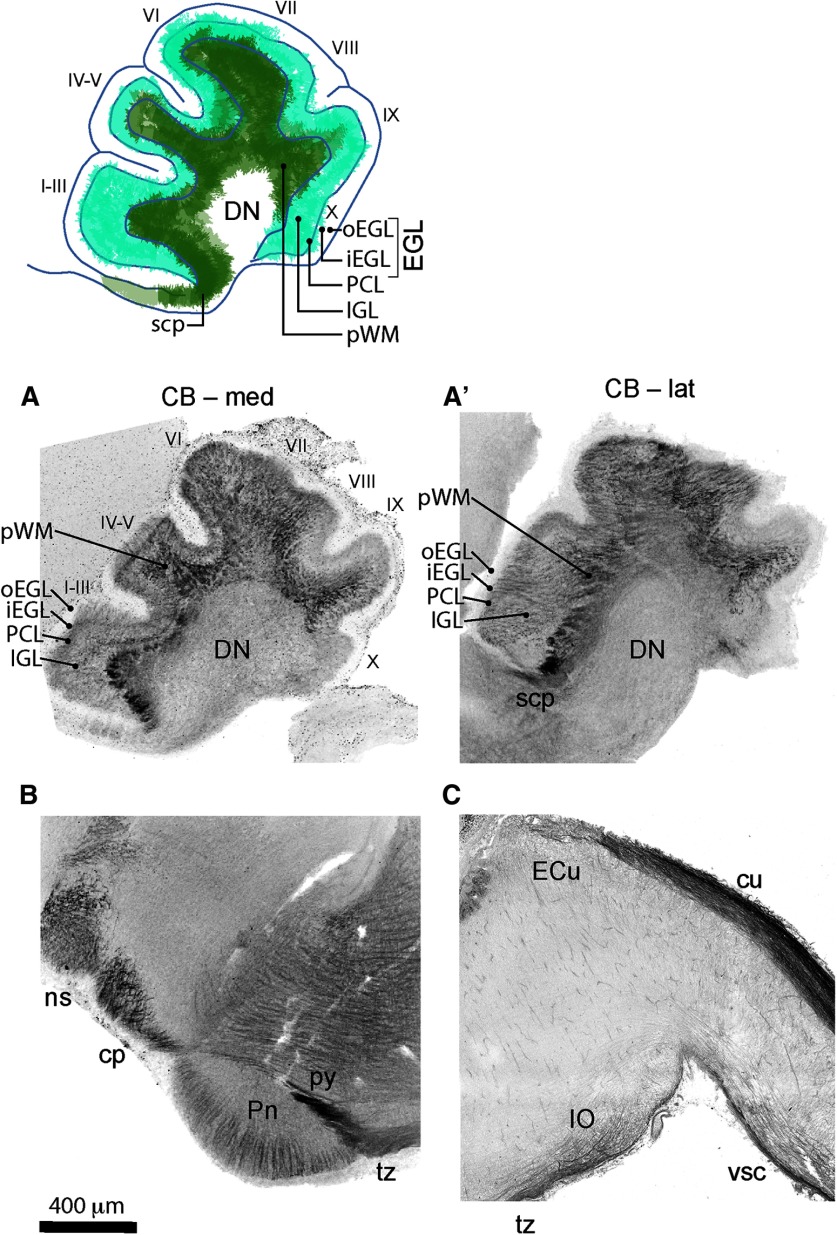
Zoomed-in view of CB1 distribution is the brainstem and the cerebellum at P0. Top row: diagram showing distribution of CB1 staining relative to the layers of the developing cerebellum (superimposed on top of the tracing of medial cerebellar section). A, A’, Thick CB1-positive fibers are prominent in the scp and pWM (darker green in the diagram). Thinner CB1-positive structures (lighter and more diffuse staining) span iEGL through PCL and IGL (turquoise in the diagram). CB1 staining is very week or absent from the oEGL, and DN. B, CB1-positive fibers are radially oriented in Pn. CB1 is prominently expressed within multiple axon tracts visible in this section through the brainstem (ns, cp, py, tz). C, CB1-positive fibers can be seen within the territory of the IO, and running through the cuneate tract (cu). Anatomical locations are adapted from Franklin and Paxinos (2008) and from Paxinos et al. (2007). CB, cerebellum; cp, cerebral peduncle; cu, cuneate fasciculus; DN, deep cerebellar nuclei; ECu, external cuneate nucleus; iEGL, inner EGL; IGL, inner GC layer; IO, inferior olivary nucleus; ns, nigrostriatal tract; oEGL, outer EGL; PCL, PC layer; Pn, pontine nucleus; pWM, presumptive white matter; py, pyramidal tract; scp, superior cerebellar peduncle; tz, trapezoid body; vsc, ventral spinocerebellar tract.